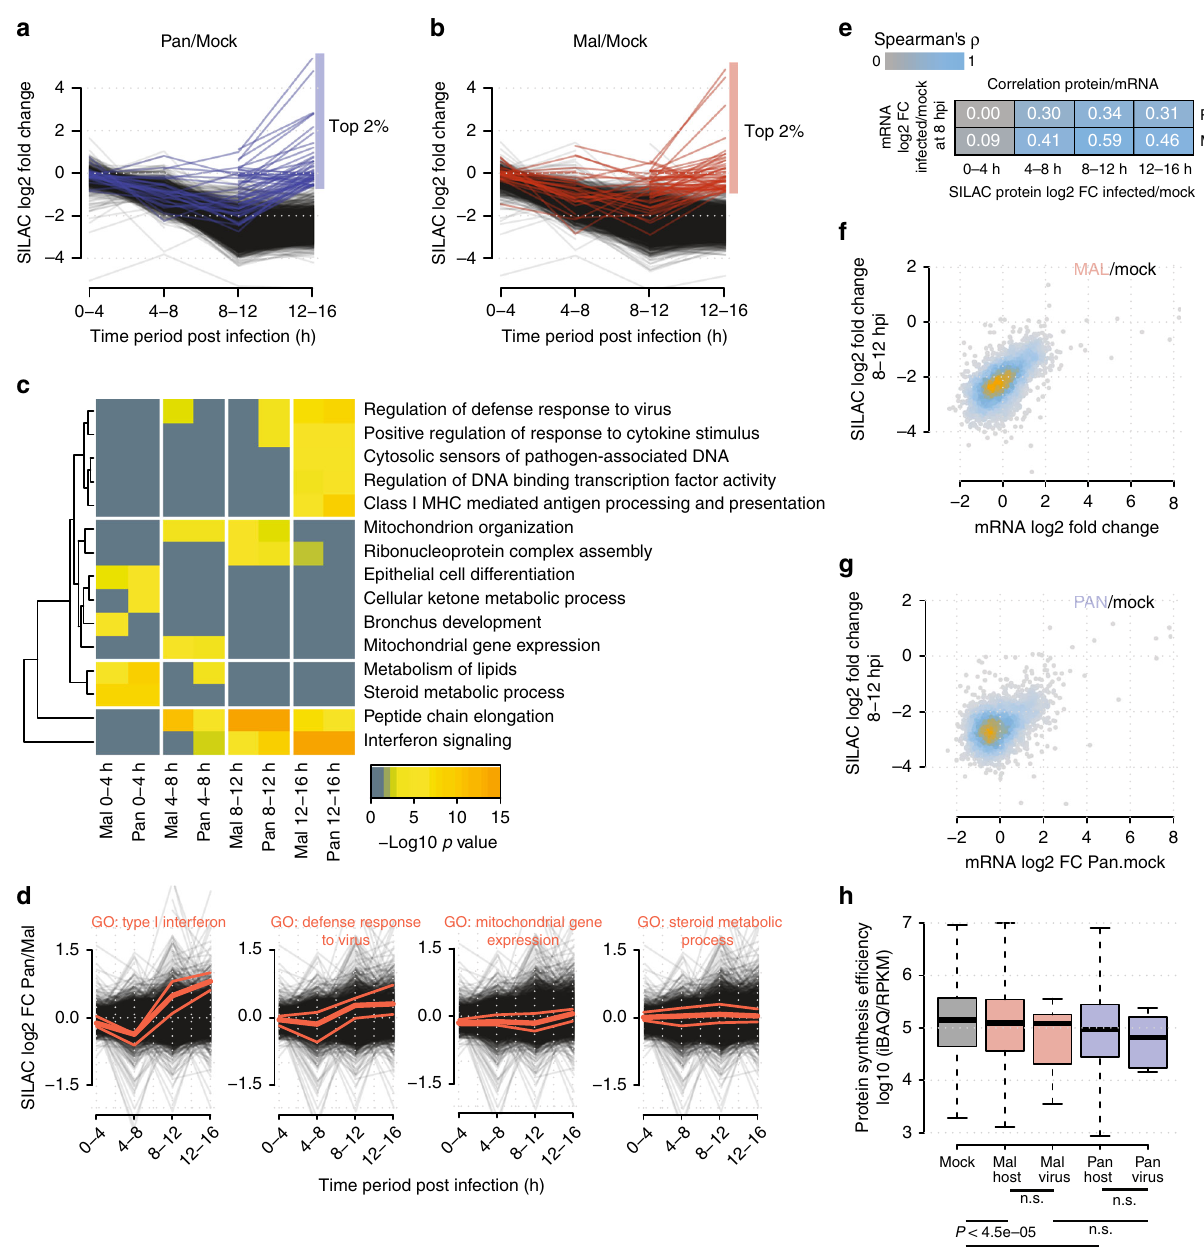
Fig. 2 The dynamic host proteome of IAV-infected cells. a , b SILAC pro fi les of host proteins infected with Pan ( a ) or Mal ( b ) compared to mock infection. The top 2% of proteins that are strongest produced during the last time period are highlighted. c Functional protein clusters least affected by host shutoff were identi fi ed. The 2% proteins with the highest ratios were selected for each time period and multi-list GO enrichment was performed. d Median, 25th, and 75th percentile of proteins related to a selected set of GO terms are highlighted in the direct SILAC comparison Pan/Mal. All other protein pro fi les in black. e Spearman ’ s rank correlation coef fi cients when comparing the indicated RNA and protein level data. f , g Scatterplot of mRNA changes vs. protein synthesis level changes in Pan/mock or Mal/mock infection conditions. Blue and orange coloring of data points re fl ects the density of data points. h Protein synthesis ef fi ciencies calculated from absolute mRNA (RPKM, 8 hpi) and protein data (iBAQ, 8 – 12 hpi) (center line, median; box limits, upper and lower quartiles; whiskers, 1.5× interquartile range, outliers (data points outside the whiskers) were removed for visibility). For the assessment of statistical signi fi cance two-sided Wilcoxon ’ s rank-sum tests were performed and p values are given (ns: non-signi fi cant). All data are based on the mean of n = 2 biological